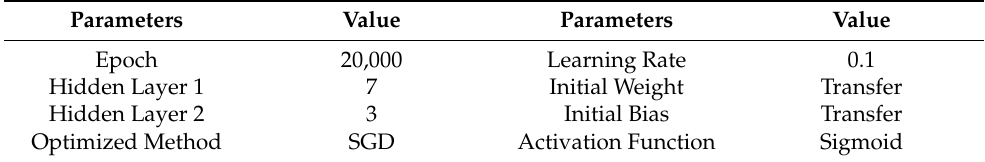
Table 6. Hyperparameters settings for the square plate (CAE-27).